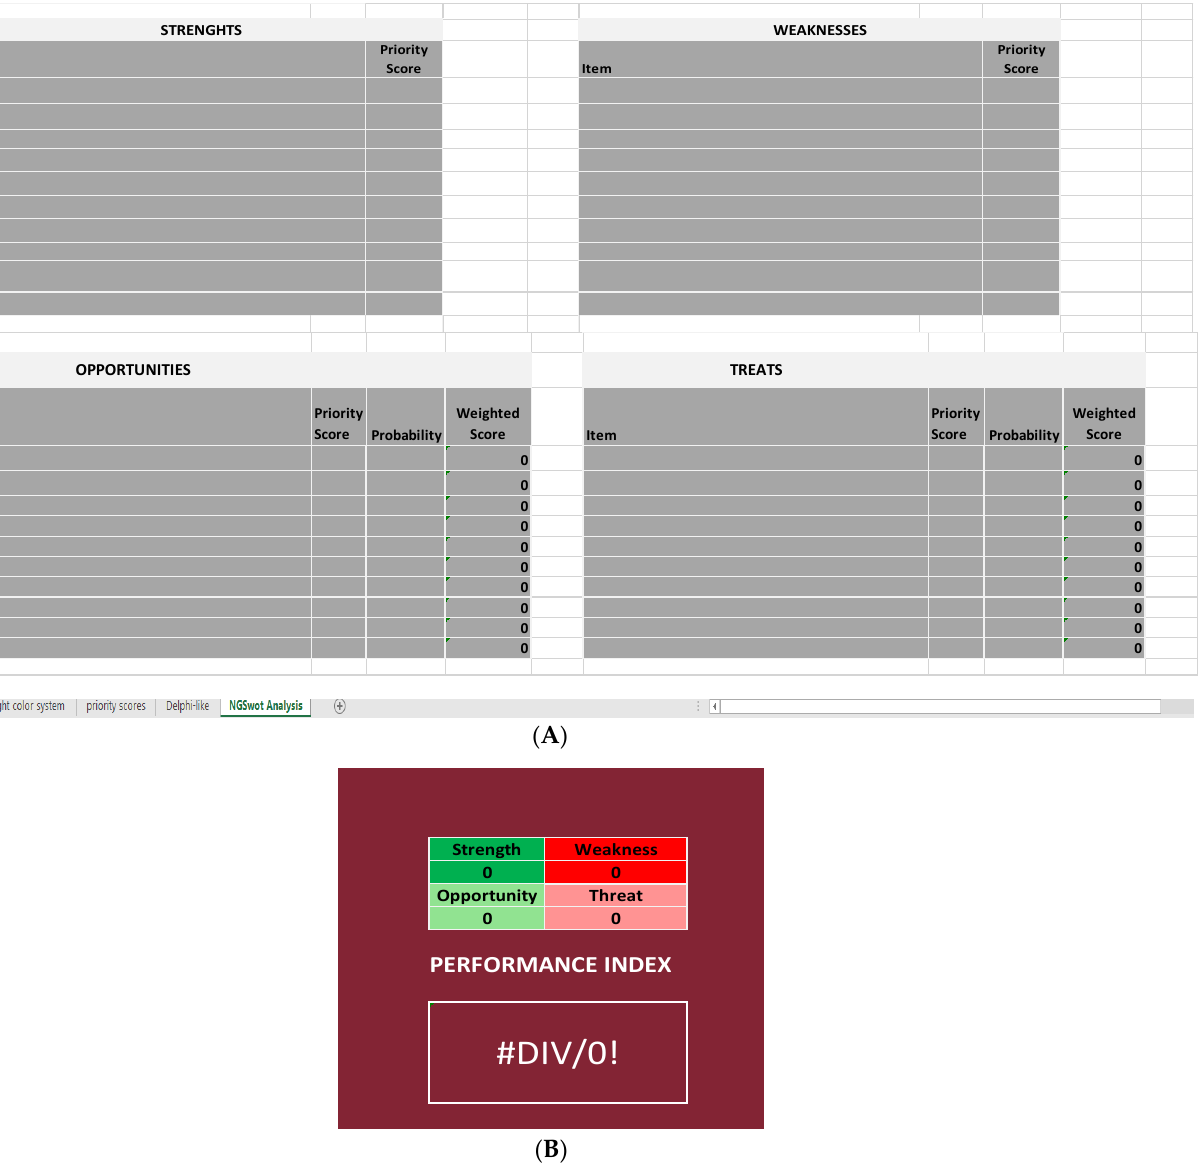
Figure 5. Extraction of the last Excel sheet of SPRIS ( NGSA ) . ( A ) Four tables used in the NGSWOT Analysis. ( B ) Sector of the sheet where the performance index is calculated.